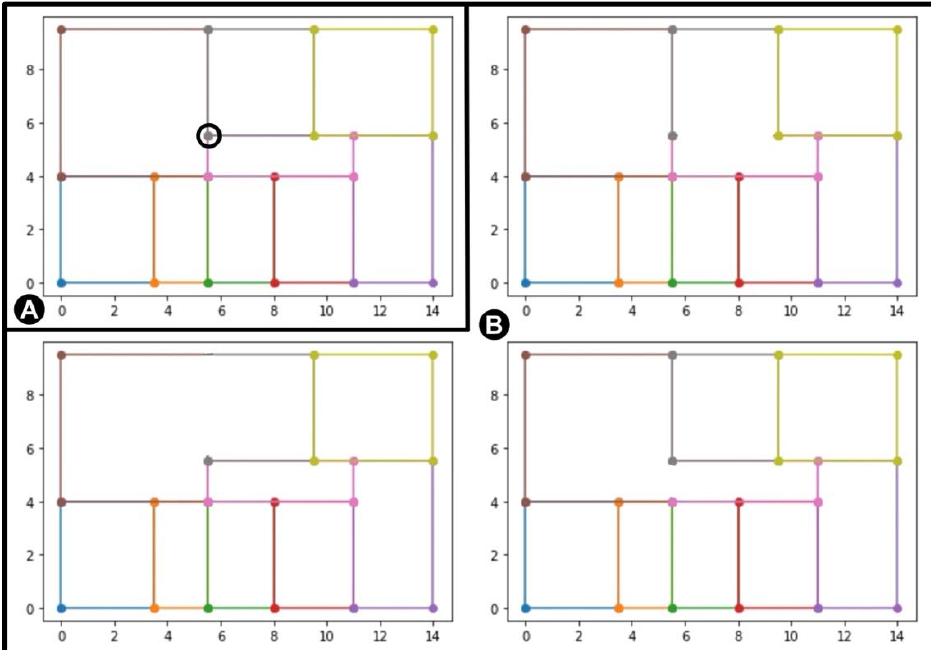
Figure 5. Deleting a point mutation. (A) Selected point. (B) Three possible realizations.